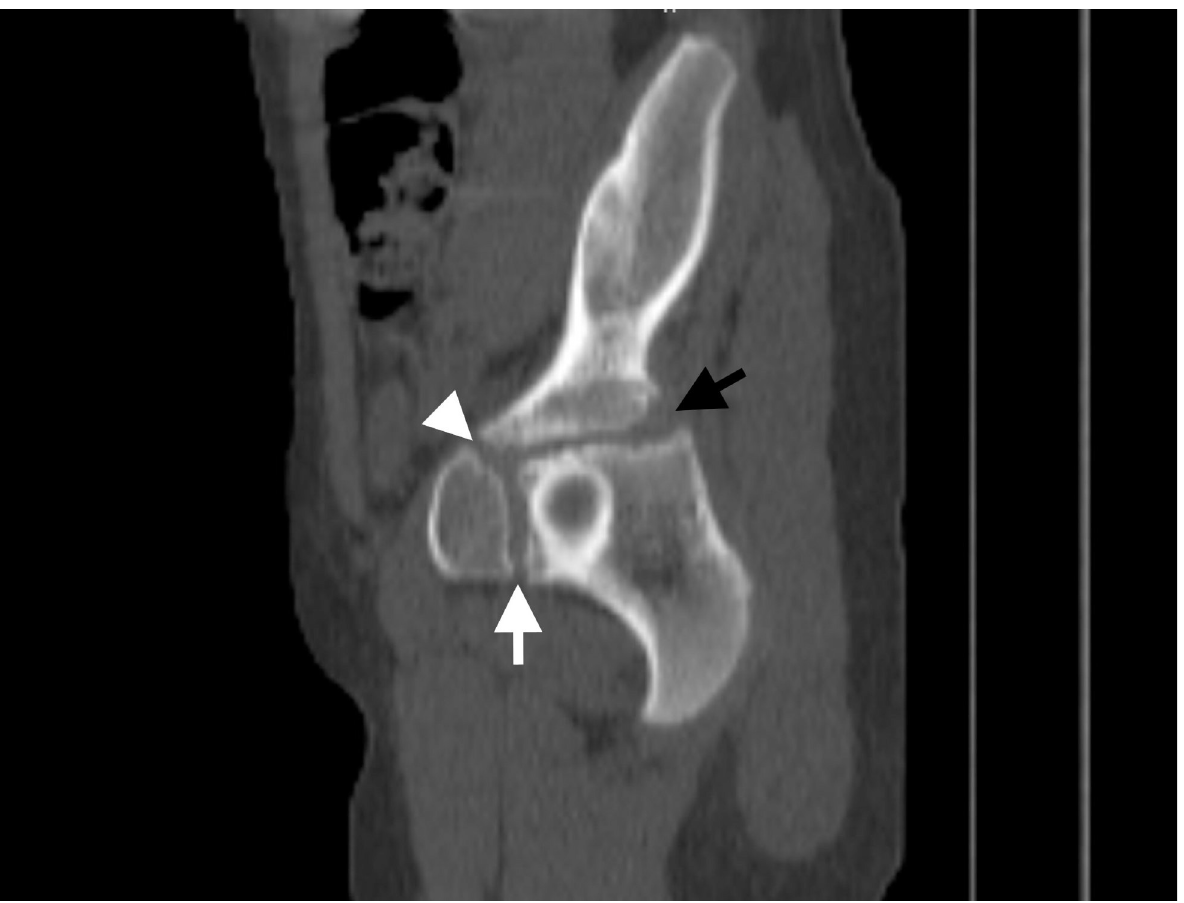
Fig 6. For a patient who is an 8-year-old girl, the sagittal plane reformatted computed tomography image shows that all three (white arrow: Ischiopubic, black arrow ilioischial, white arrowhead: Iliopubic) synchondrosis regions are open.